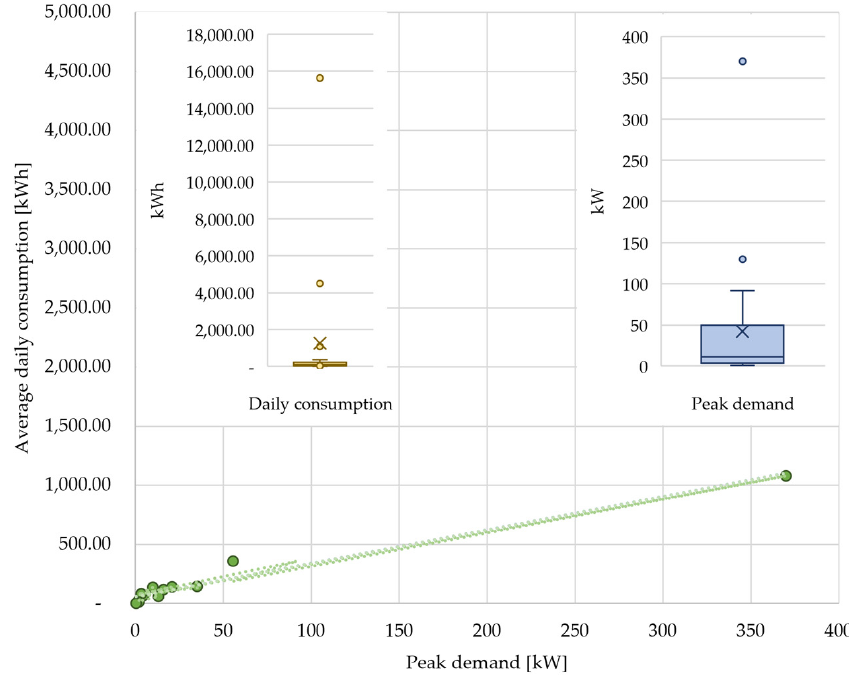
Figure 3. Peak demand and average daily electricity consumption in off-grid systems.